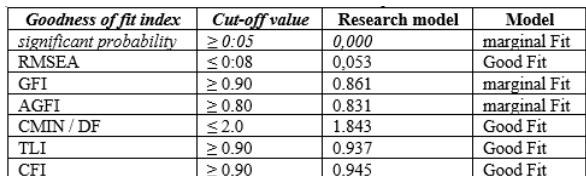
Table 3. Test results Goodness of Fit